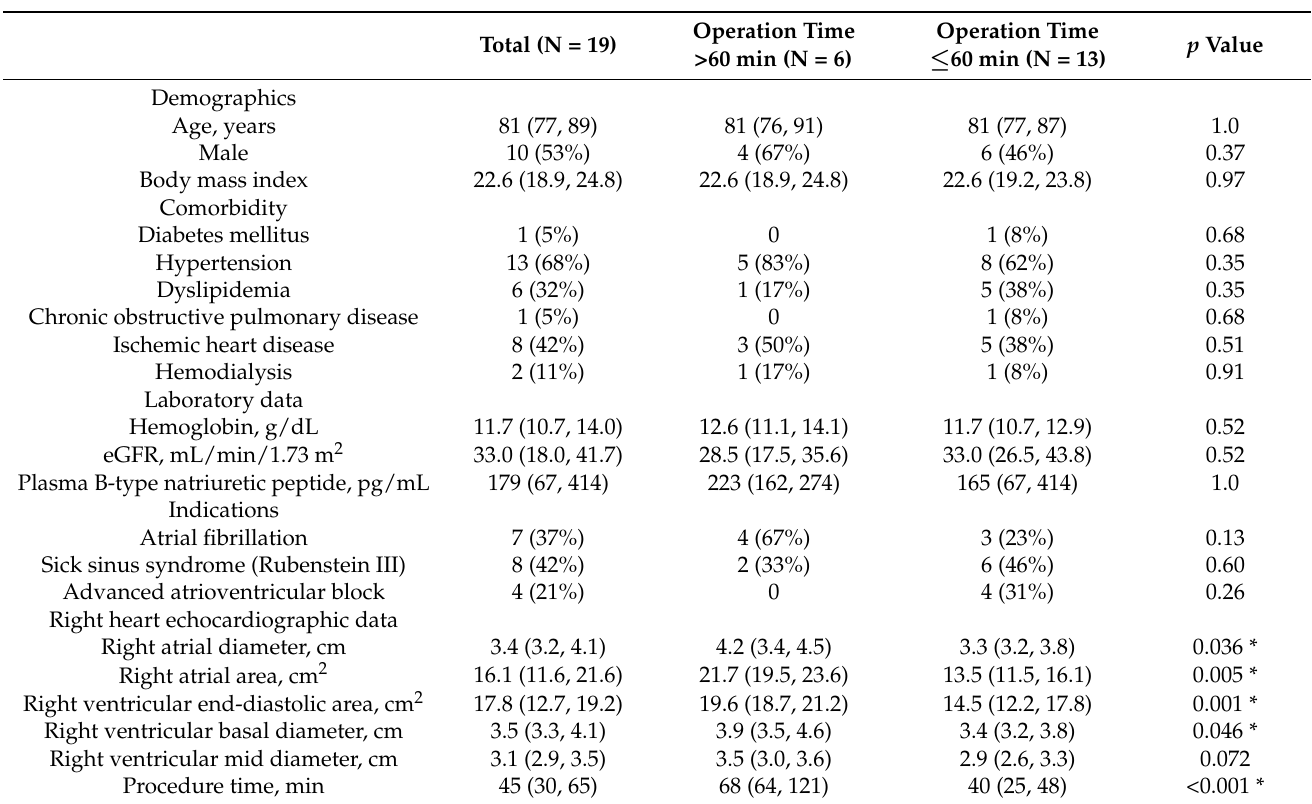
Table 1. Baseline characteristics.